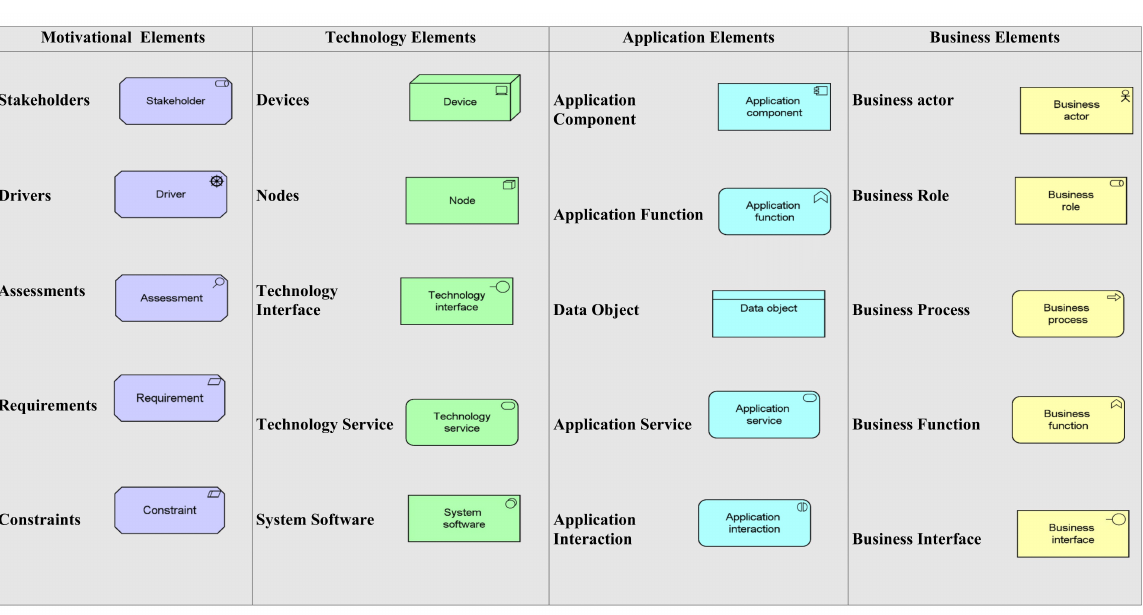
Figure 2. Selected set of elements from